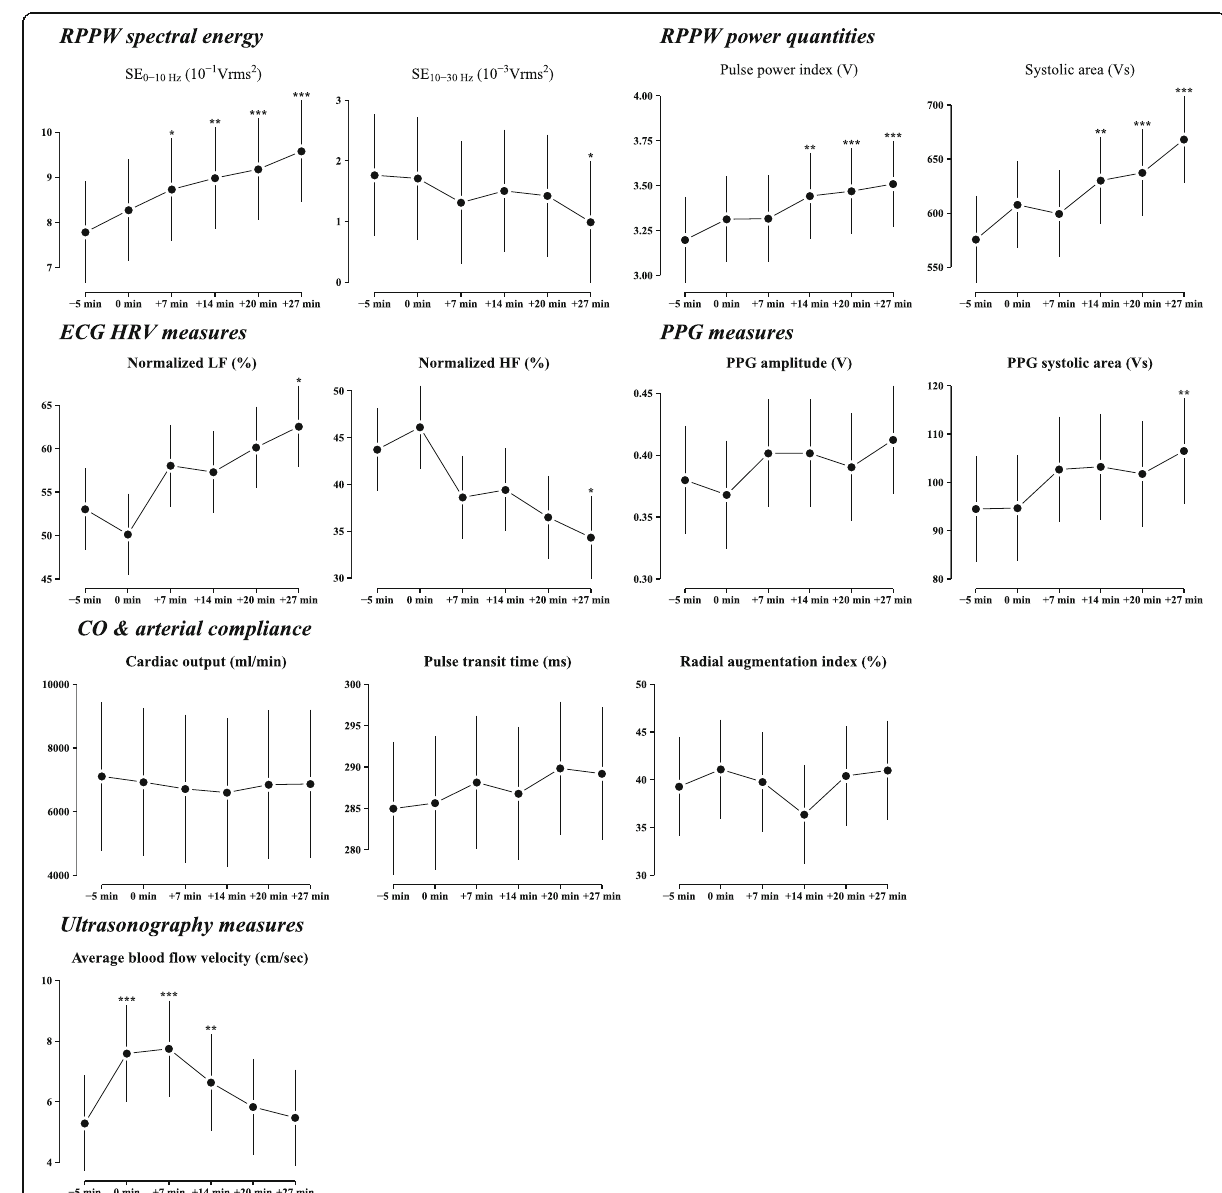
Fig. 4 Estimated mean profiles of hemodynamic and RPPW measures for the main discussion. Each dot and line represent the least squared mean and its standard error, derived from the identical LMM used in the results shown in Tables 3, 4 and 5. Asterisks indicate the magnitude of statistical significance for the mean difference between baseline ( − 5 min) and the other assessment stages. Detailed descriptions of the tests are provided in Table 3, 4 and 5. The family-wise type I error rate was adjusted with Dunnett ’ s test. ***, p < 0.001; **, p < 0.01; *, p <